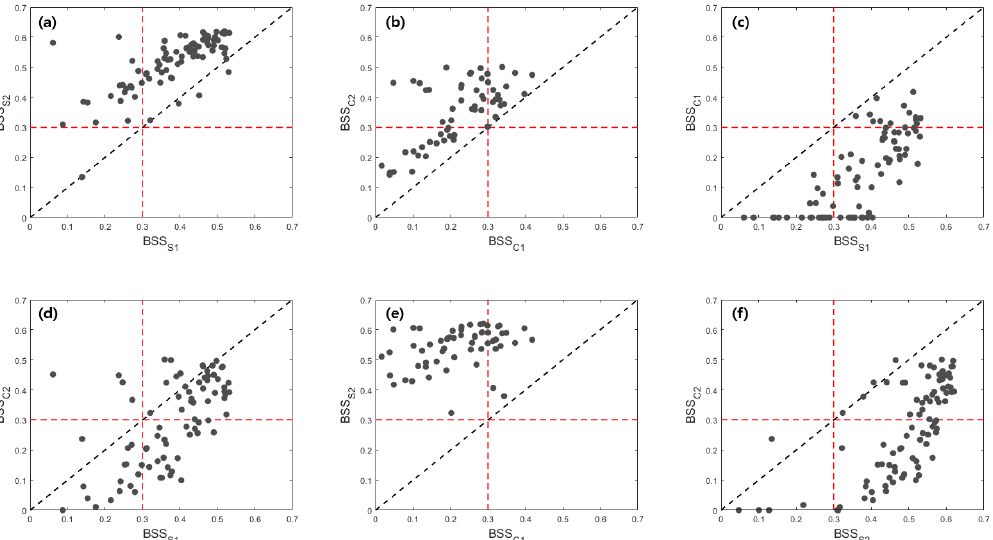
Figure 8. Comparison of BSS calculated in each storm condition (S1 and S2 ( a ), C1 and C2 ( b ), S1 and C1 ( c ), S1 and C2 ( d ), C1 and S2 ( e ) and S2 and C2 ( f )) when the BSS on the x -axis is higher than 0. It should be noted that BSS is plotted as 0 if BSS on the y -axis is 0 or lower for clarity. The red dashed line indicates the threshold value of reasonable model performance [26] (BSS = 0.3).